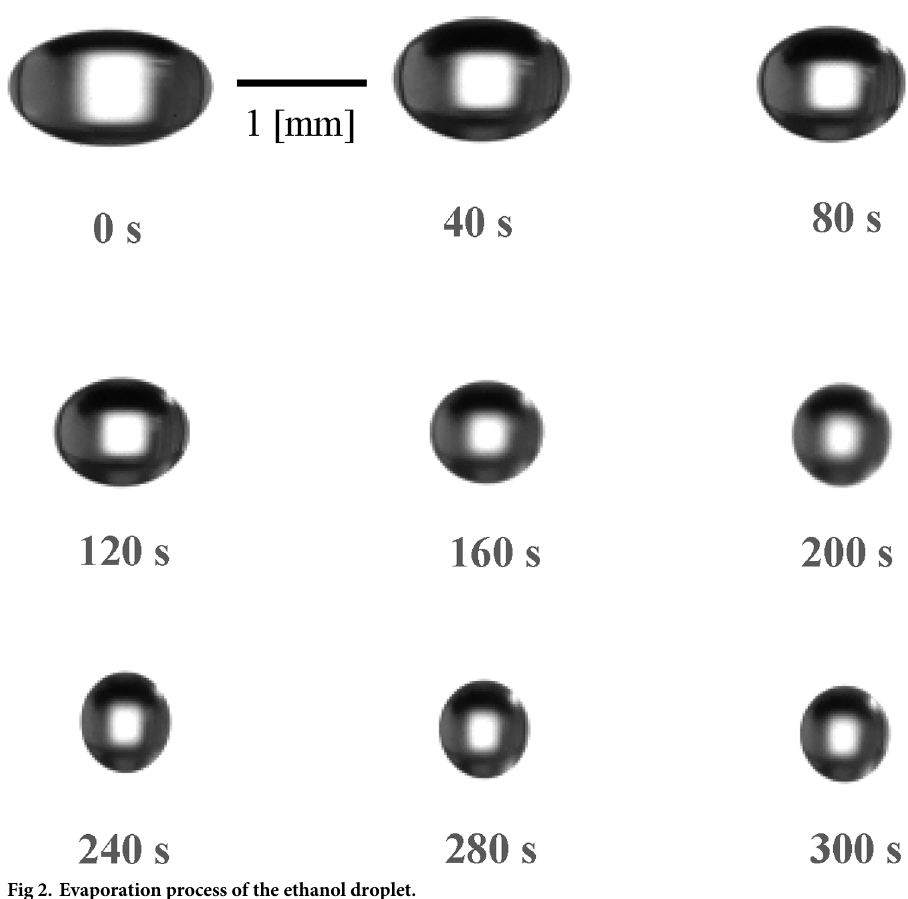
Fig 2. Evaporation process of the ethanol